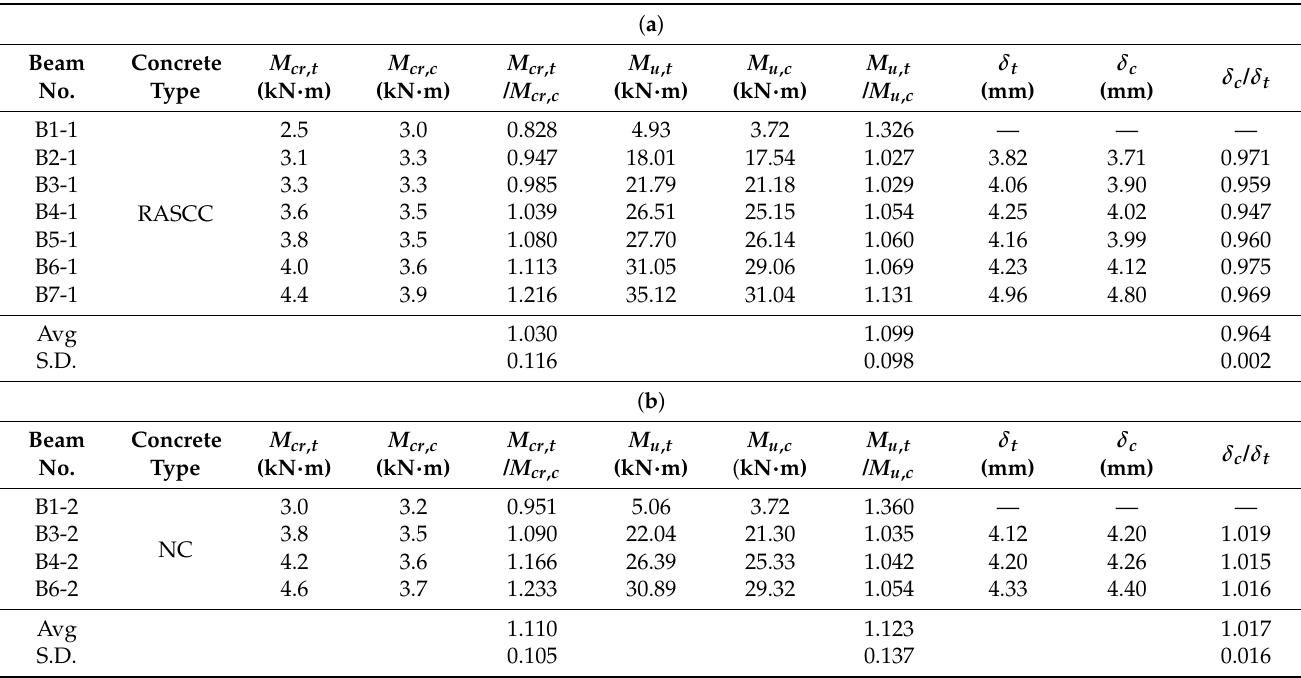
Table 5. ( a ). Comparison of experimental and code calculation results for RASCC beams. ( b ). Comparison of the experimental and code calculation results NC beams. ( a )